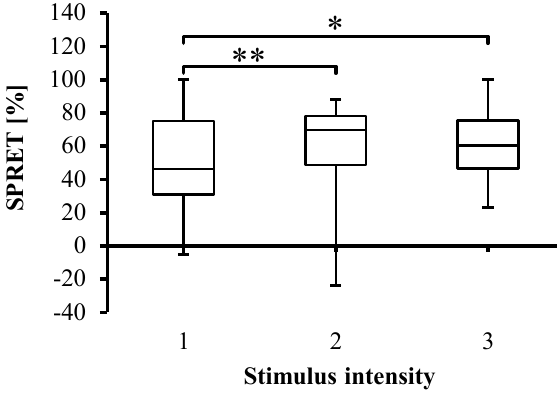
Fig. 6: Box-plot with medians, quartiles and the min and max as whiskers, showing the SPRET percentage for all participants with respect to the stimulus intensity.* p <0.05 and ** p <0.005.